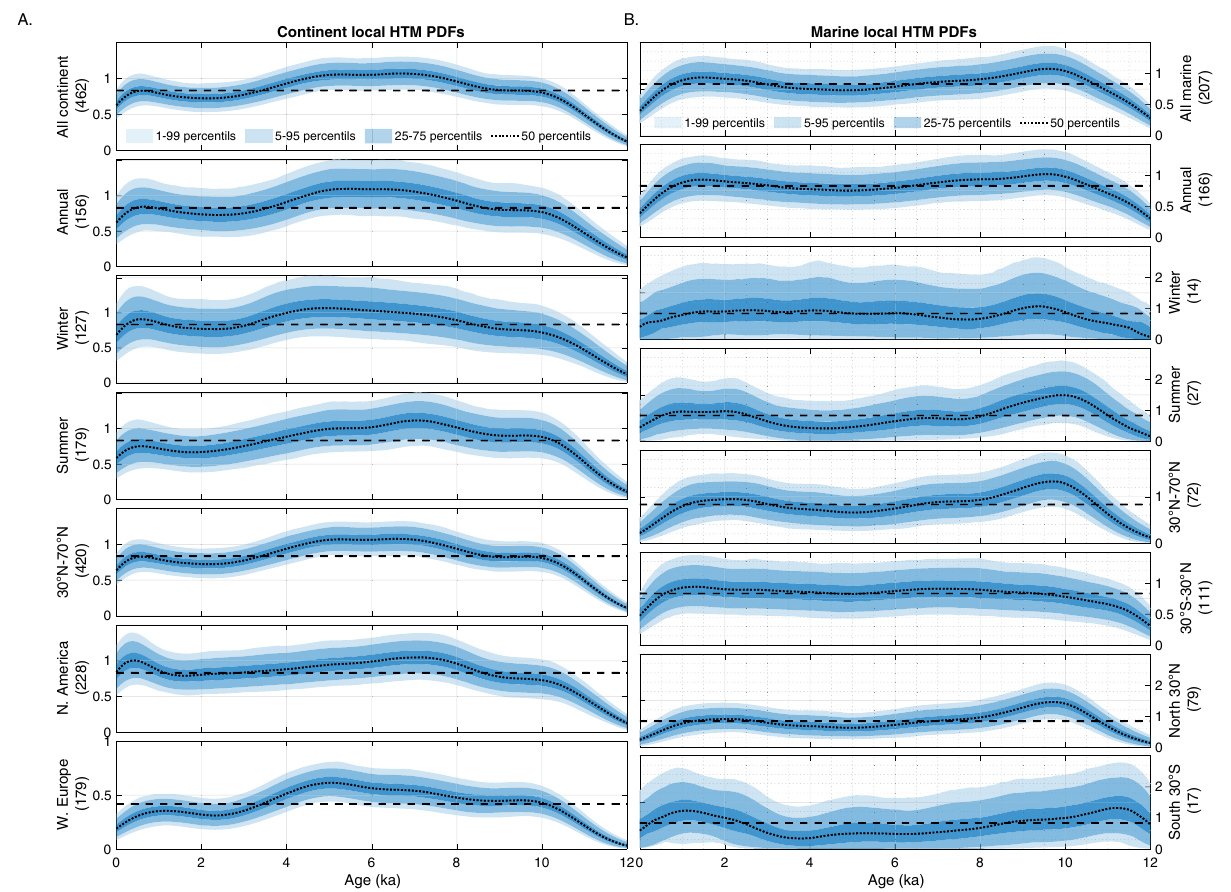
Fig. 6 | Temporal structure of the local Holocene Thermal Maximums. Tem- poral structure of the local HTMs for different subsets of continental ( A ) and marine( B )proxies.Dottedlinesshowthemedianvaluesacross10,000realizations